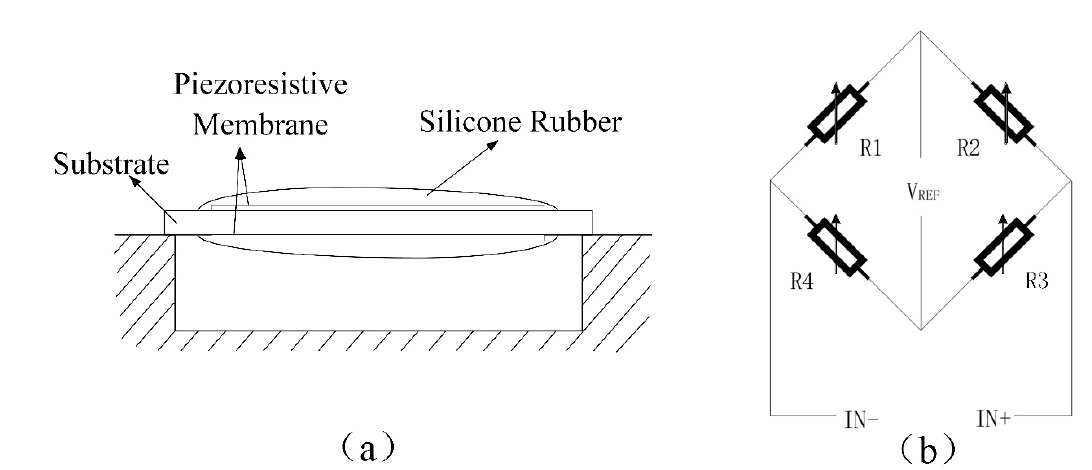
Figure 1. Self-packaging pressure sensor ( a ) and Wheatstone bridge ( b ).